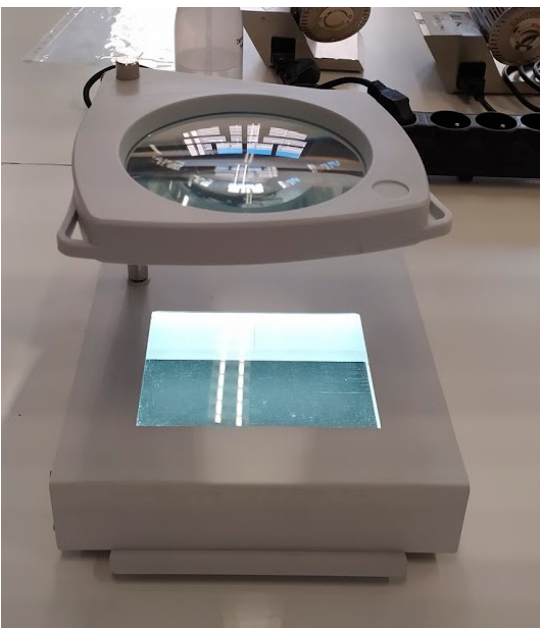
Figure 2. Prototype of the microplate viewer by JP Selecta, used for the visual reading. The background at the bottom can be changed to